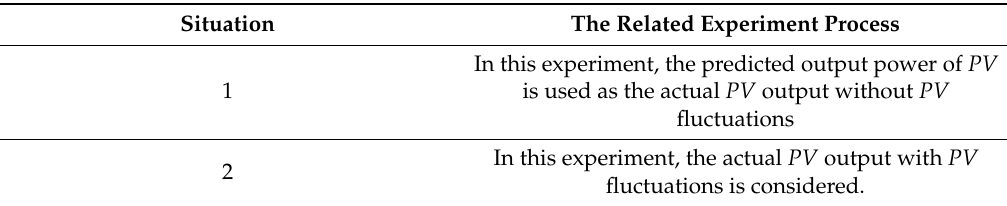
Table 9. The operation process in the Experiment 2.